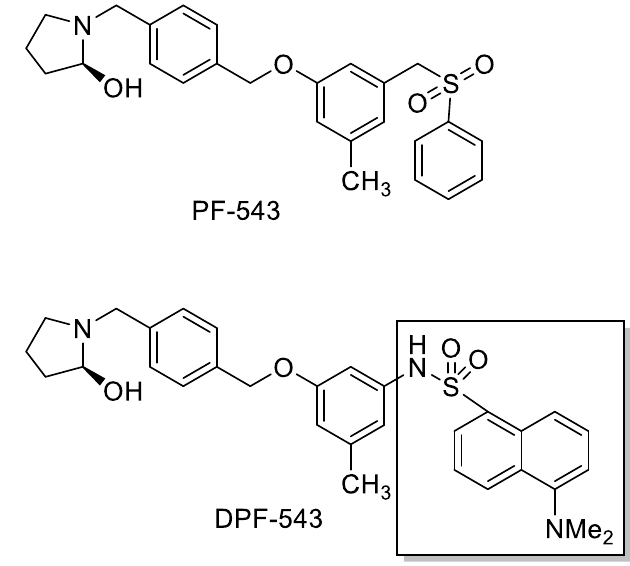
Figure 1. Structure of PF-543 and DPF-543.